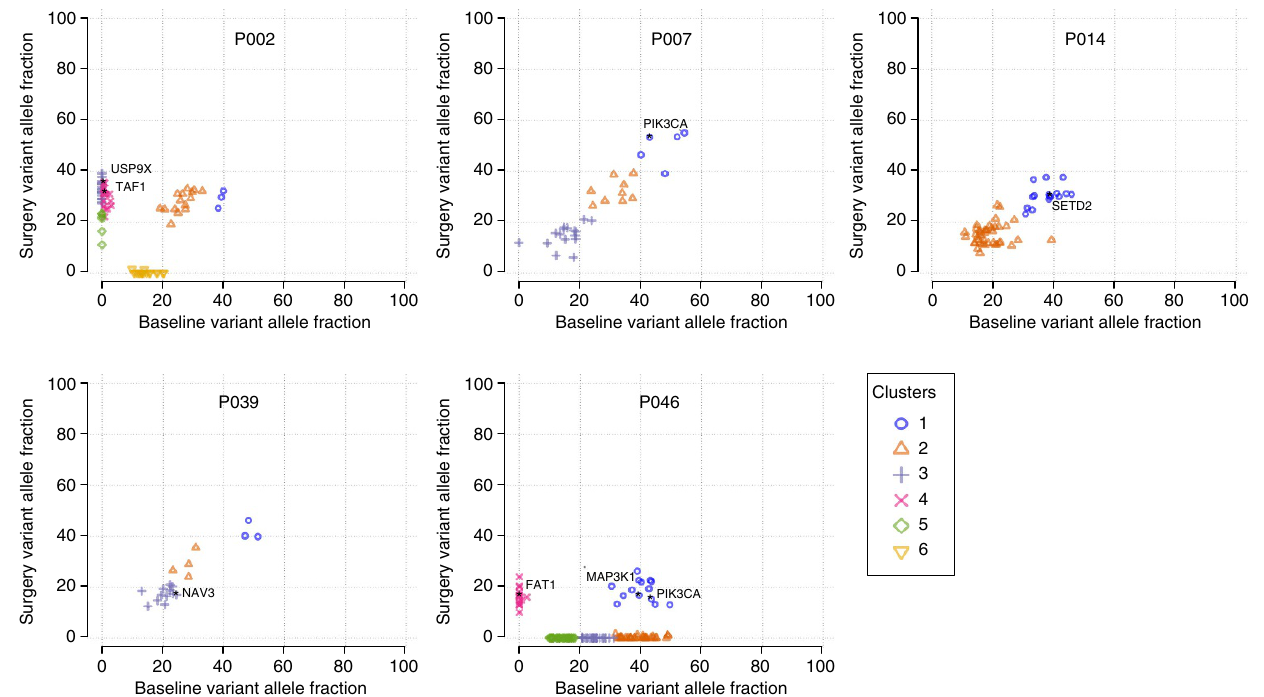
Figure 3 | Intra-tumour heterogeneity. Five examples with clear intra-tumour heterogeneity are shown (Supplementary Figs 6–8 for plots of all samples). Some patients had clusters present in both samples (P007, P014 and P039), while others had several clusters that were found in either the baseline or surgery sample (P002 and P046). The variant allele fractions of mutations are shown. Whole-exome sequencing was used for copy-number assessment and only mutations in copy-number neutral regions were plotted. Colours indicate assigned clusters by SciClone (Methods). Cancer-related genes listed in Supplementary Table 4 are labelled in the plots.